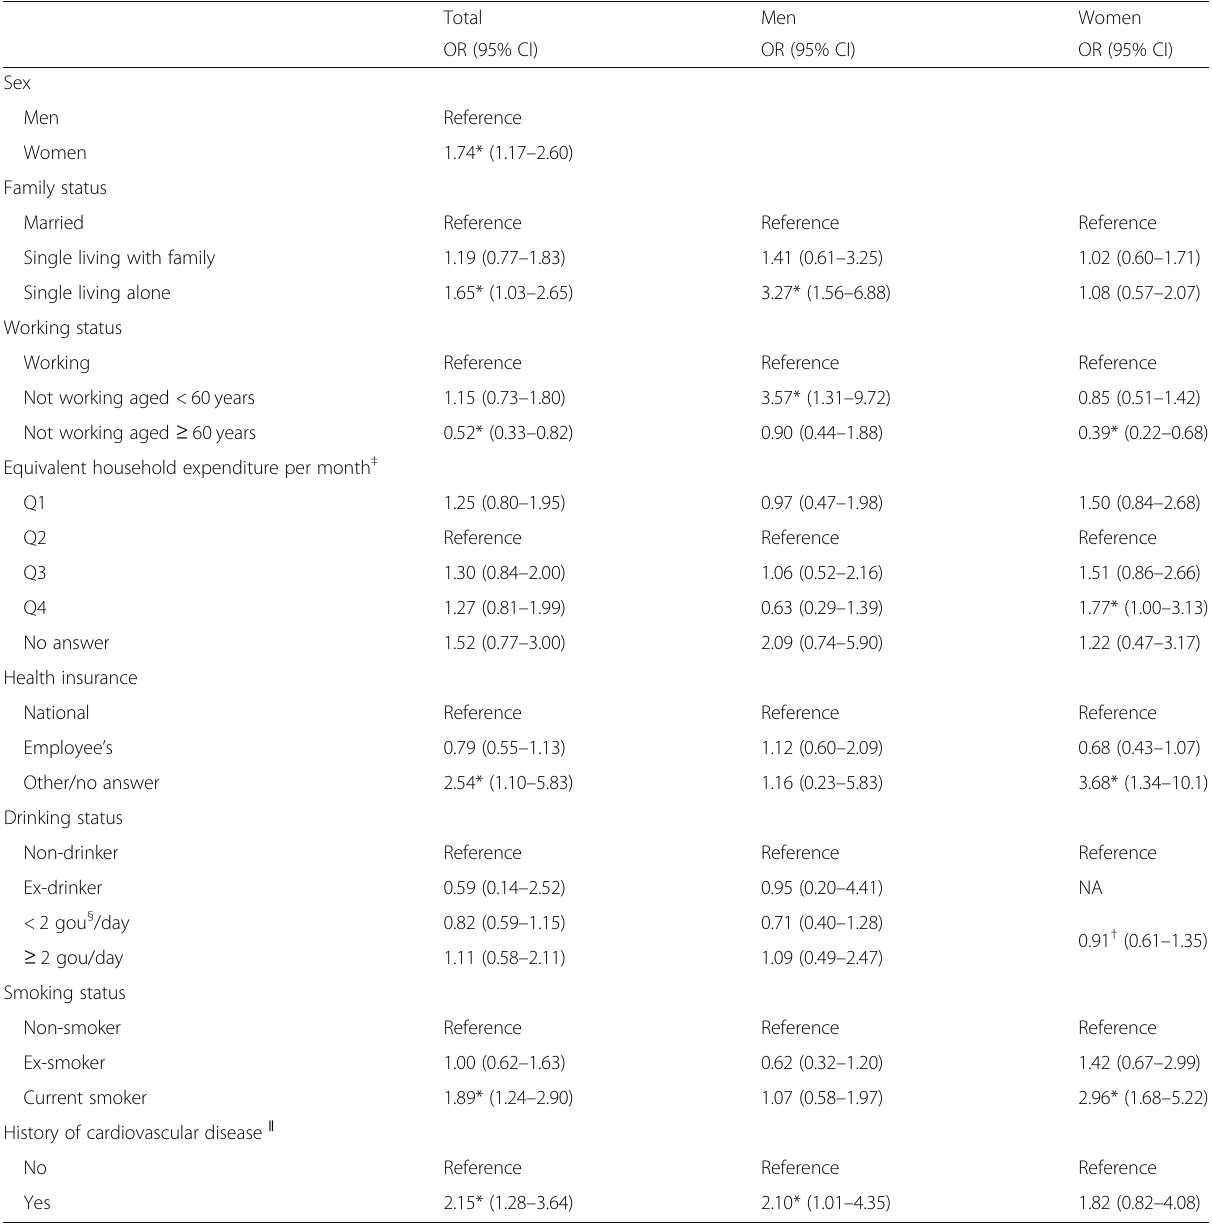
Table 3 Socioeconomic/lifestyle factors and multivariable adjusted odds ratios ¶ of depressive tendencies (Kessler 6 ≥ 9) in Japanese men and women aged 20 years and older. NIPPON DATA2010 baseline survey ( n =